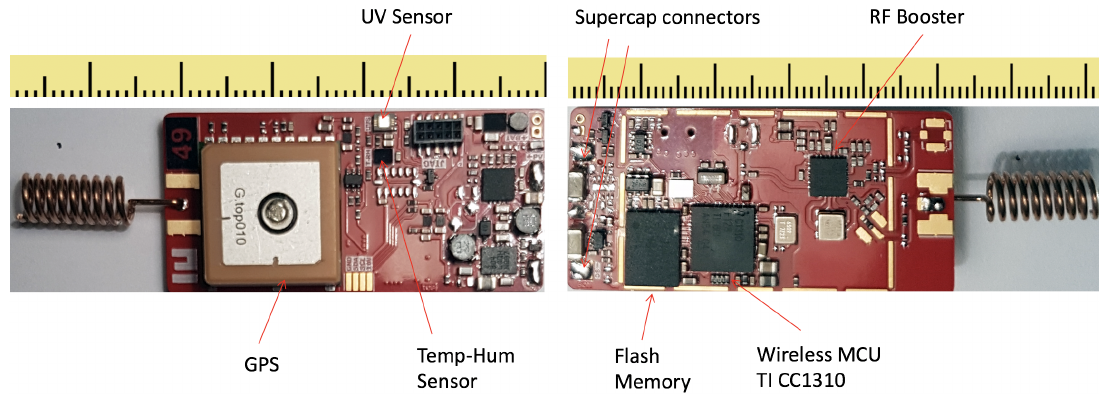
Figure 2. Sensor board components placement.